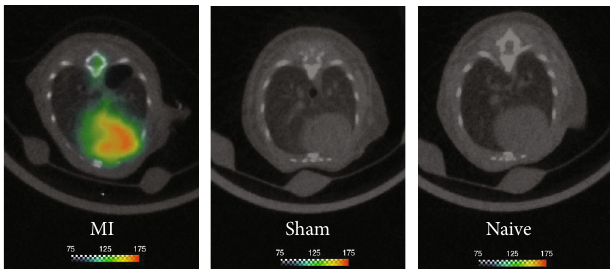
Figure 2: 18 F-FGA/PET of MI in mice. Mice belonging to MI, sham, and naïve groups were injected with 300 μ Ci of 18 F-FGA. PET was performed after 1 h. Only MI mice showed uptake in the heart; sham and naïve mice did not show any detectable uptake in the